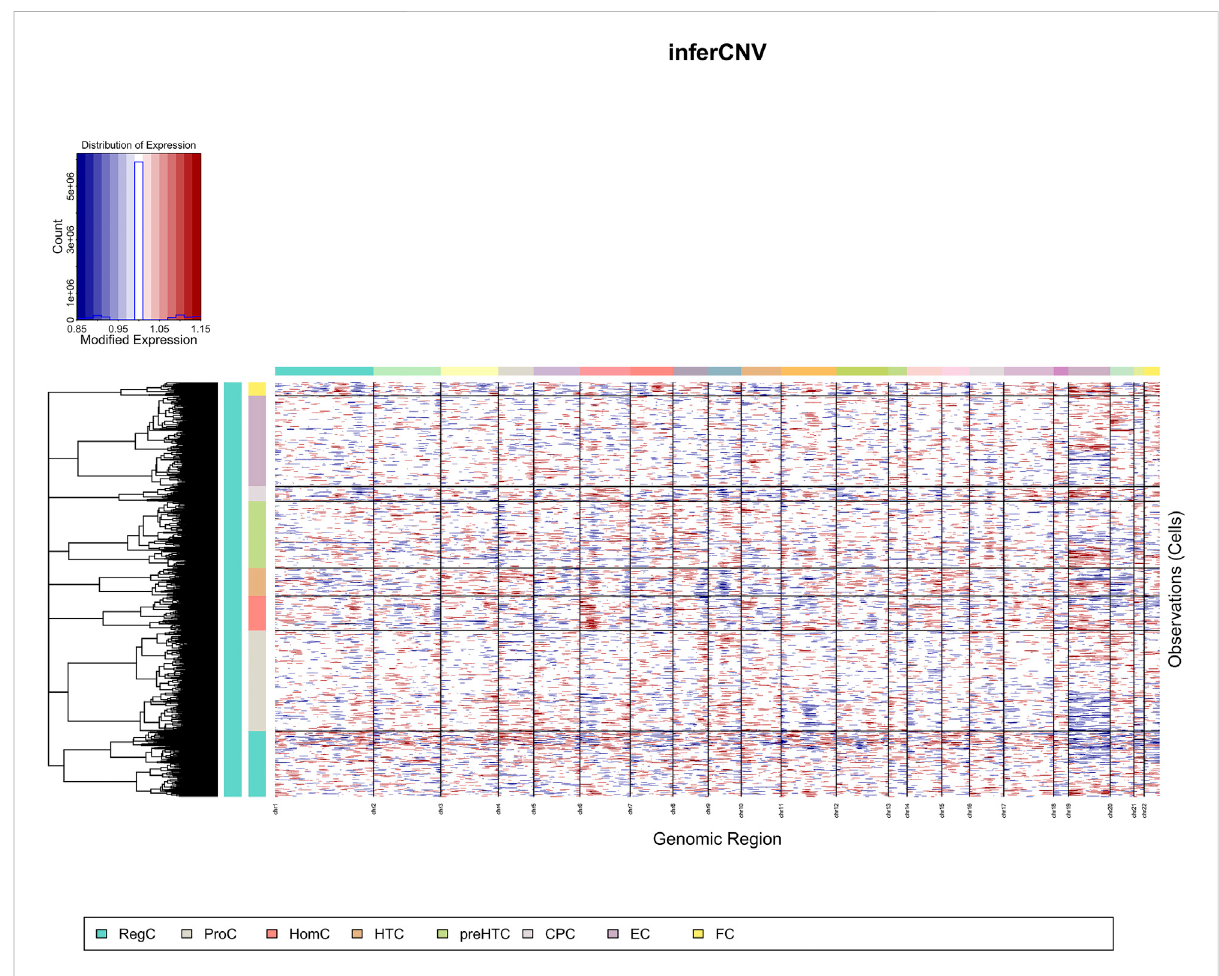
FIGURE 2 CNV landscape (the X-axis represents chromosome, and the Y-axis represents cell